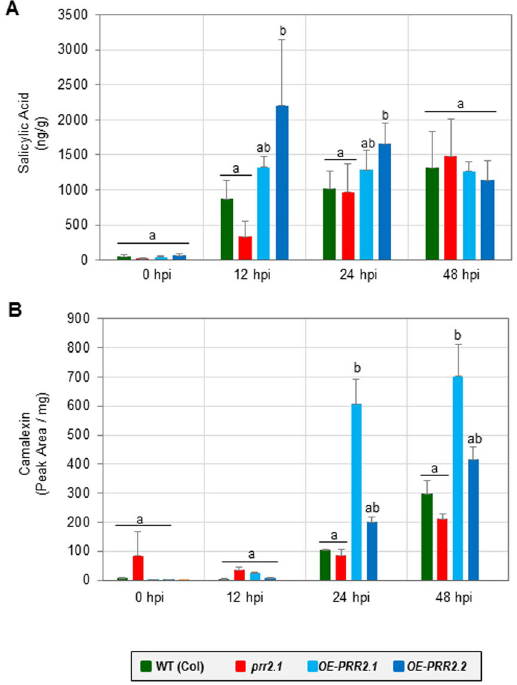
Figure 5. Quantification of total SA and camalexin content in prr2 genotypes in response to Pseudomonas syringae inoculation. ( A ) Quantification of SA levels in leaves of 4-week-old plants of Arabidopsis thaliana in control conditions or after inoculation with Pst DC3000. SA quantifications were performed at 0 h, 12 h, 24 h and 48 h post-inoculation in WT (Col) and prr2 plants ( prr2 . 1 , OE-PRR2 . 1 and OE-PRR2 . 2 ) with Pst DC3000 at 10 7 cfu.mL − 1 . ( B ) Quantification of camalexin levels in leaves of 4-week-old plants of Arabidopsis thaliana in control conditions or after inoculation with Pst DC3000. Camalexin content was measured in WT, prr2 and OE- PRR2 lines after inoculation with Pst DC3000. For A and B , each bar represents the mean and standard error of three biological replicates. Bars sharing the same letter are not significantly different according to Dunnett’s test (p-value <